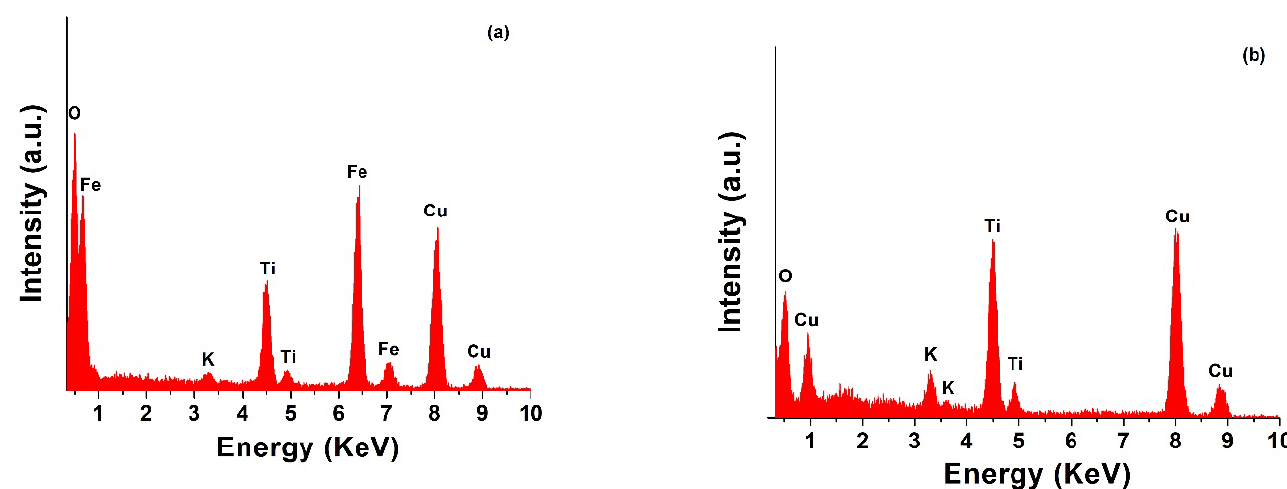
Figure 2. EDS spectra of TiO 2 NW@Fe 2 O 3 ( a ) and TiO 2 NW@CuO ( b ) nanocomposites.